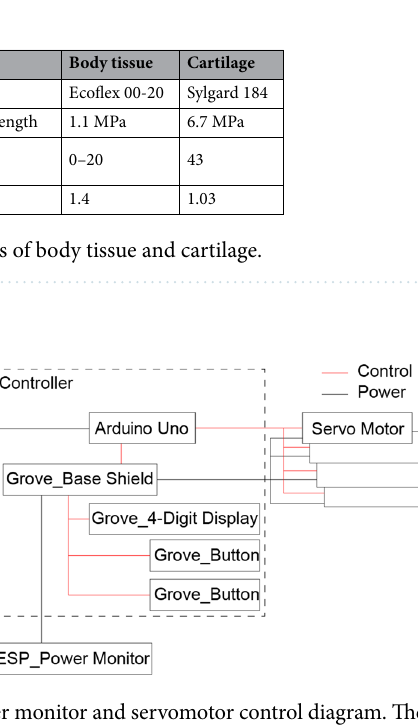
Figure 9. Power monitor and servomotor control diagram. The black line is the power supply electrical wires. The red line is connection for controls the electrical wires. The dashed line depicts the controller